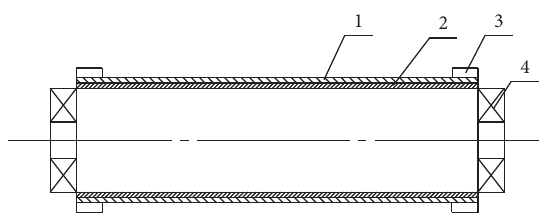
Figure 10: Structure diagram of a conductive roller. 1, conductive layer; 2, insulation layer; 3, sliding ring; 4,